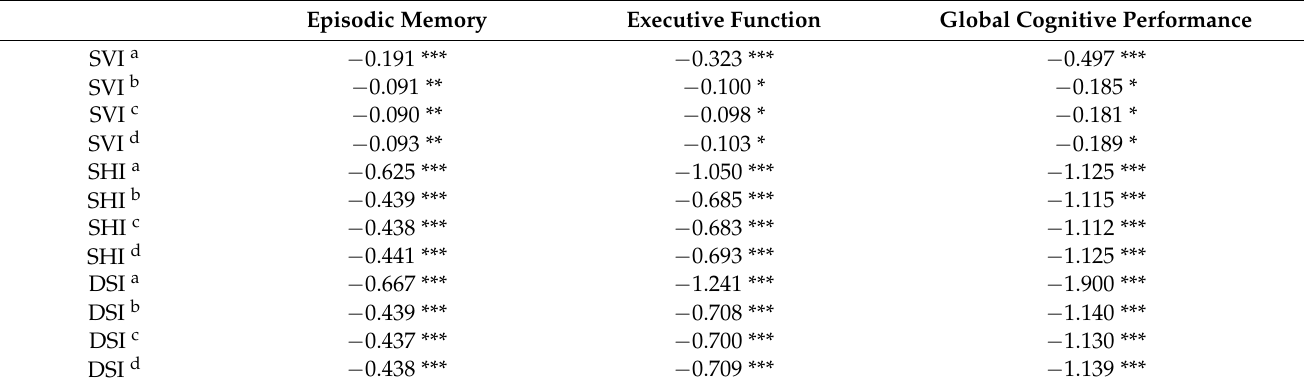
Table 2. Linear mixed model was used to describe the correlation between baseline sensory statuses and subsequent cognitive decline over 8 years. Episodic Memory Executive Function Global Cognitive